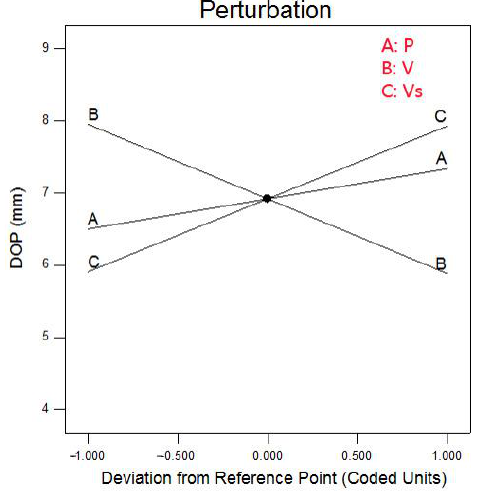
Figure 6. Influence of welding parameters on penetration. Figure 7 is the response contour map and isoline diagram of the influence of parameters on weld penetration.